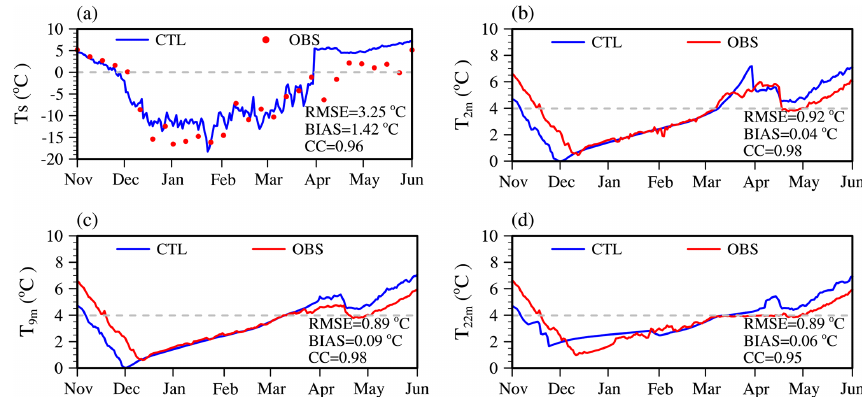
Figure 4. The daily average water temperature observed and simulated in CTL of (a) the surface (Ts), (b) 2m, (c) 9m, and (d) 22m in Ngoring Lake from November 2015 to June 2016. The dotted lines represent T md 3.98 ◦